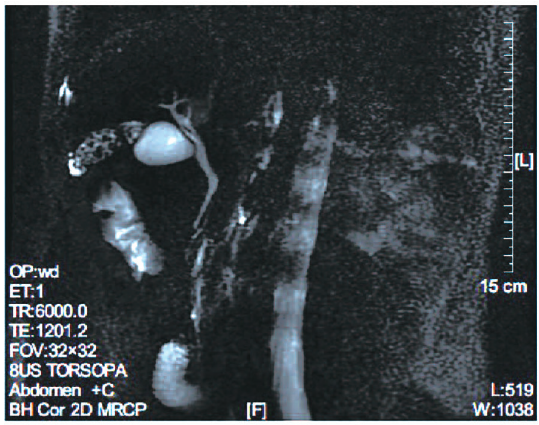
Figure 1 Magnetic resonance cholangiopancreatography. The anatomy structures of the gallbladder, cystic duct, common hepatic duct and common bile duct are